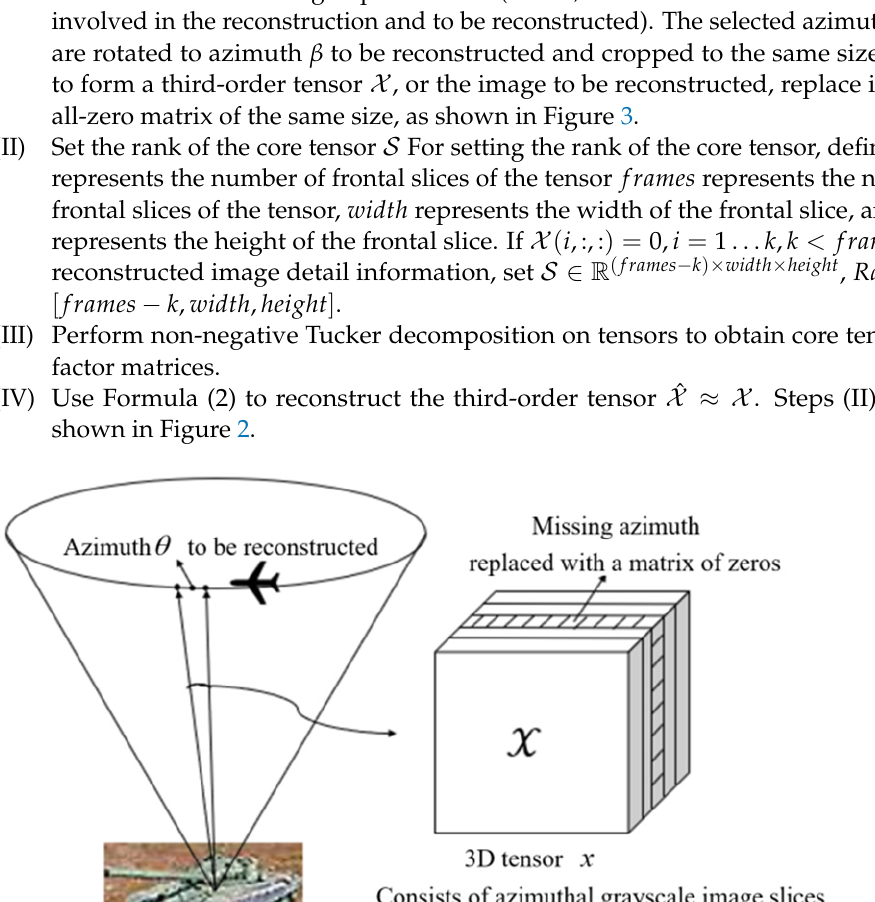
Figure 2. Tensor decomposition and reconstruction. Figure 2. Sparse tensor construction.